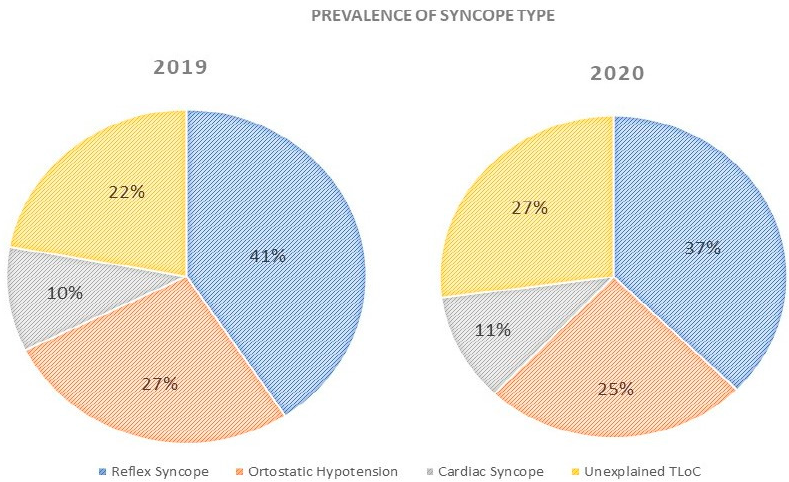
Figure 4. Prevalence of syncope type during 2019 and 2020 study periods.